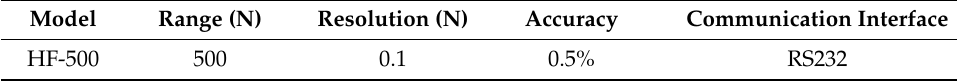
Figure 22. The photos of the tank and experimental platform. Table 11. The parameters of the tension sensor.